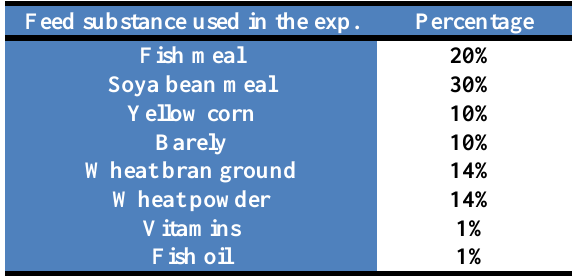
Table, 1: Feed component% and chemical analysis % of the experiment diets calculate on basis of dry matter.